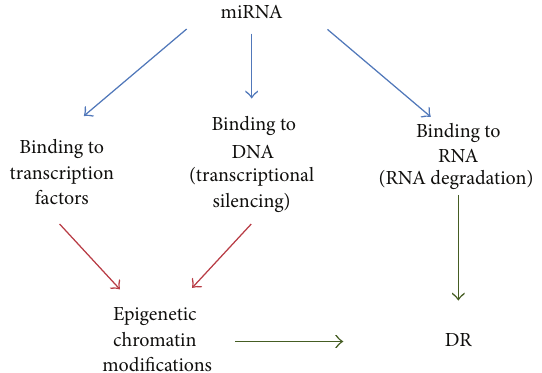
Figure 2: Scheme of miRNA-induced epigenetic modifications. miRNA modulates gene expression in various manners: (i) by directly binding to DNA into the gene promoter region; (ii) by miRNA binding to the 3 󸀠 -untranslated region of target genes, leading to either posttranscriptional silencing and translational repression or RNA degradation, and miRNAs which can interact with transcription factors and RNA-binding proteins that regulate gene transcription and RNA processing. The binding of miRNA to transcription factors and to DNA regions leads to epigenetic modification of the chromatin, which in turn participate to DR